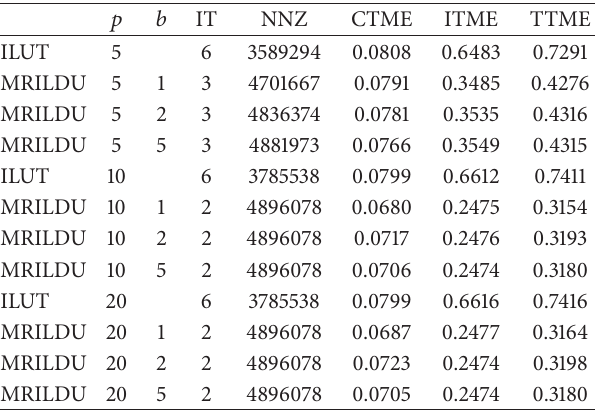
Table 8: Iteration results for matrix sparsine.